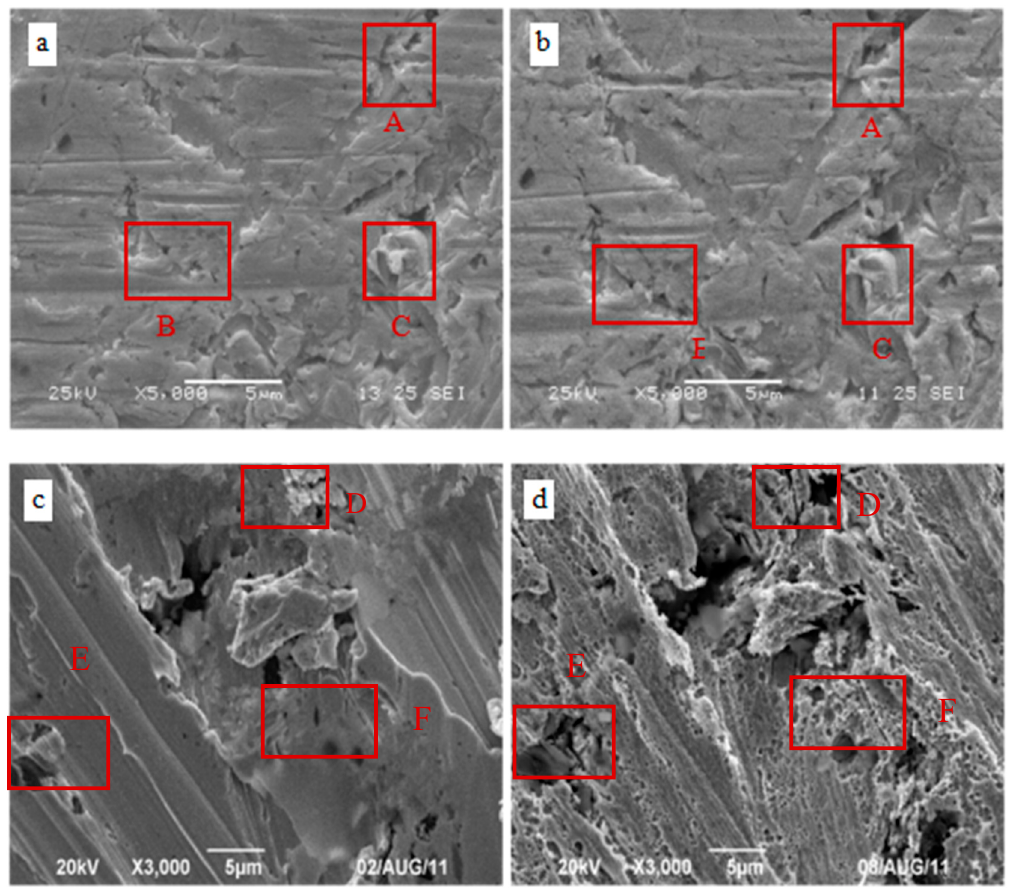
Figure 5. SEM images of the gold surface before and after gold dissolution ( a and c : original gold plate, b : conventional cyanidation, and d : Bi intensification